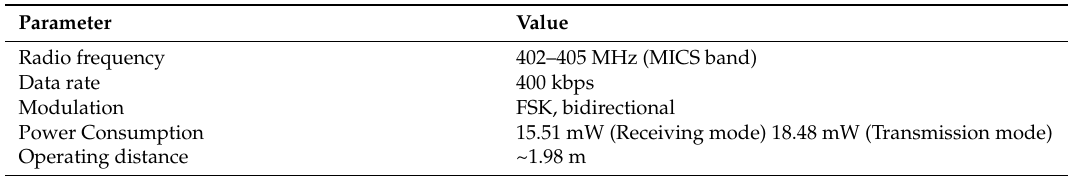
Table 5. Characteristics of the wireless data communication.